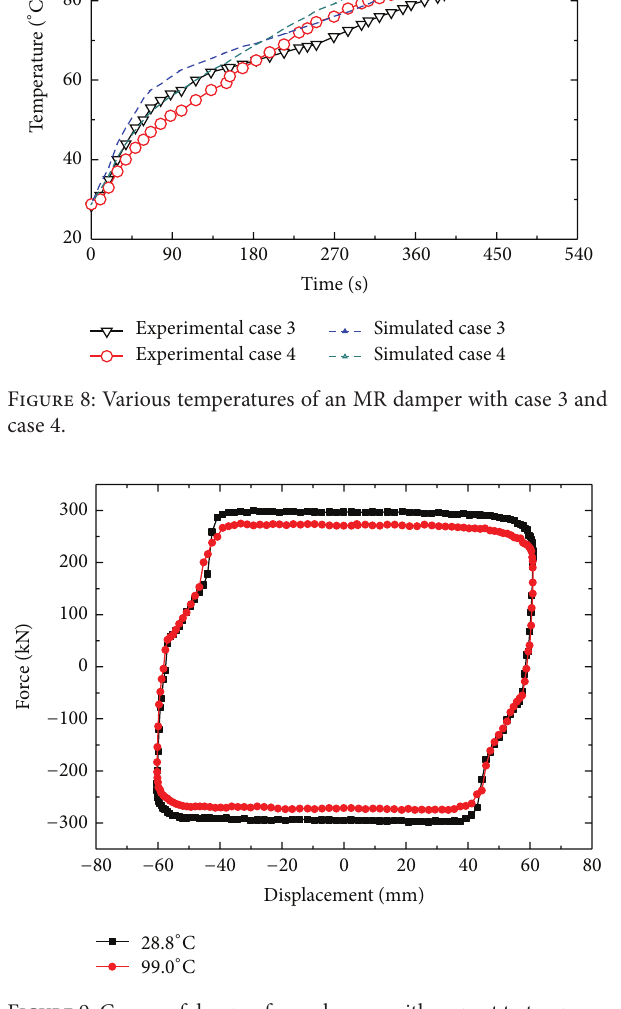
Figure 9: Curves of damper force changes with respect to tempera-